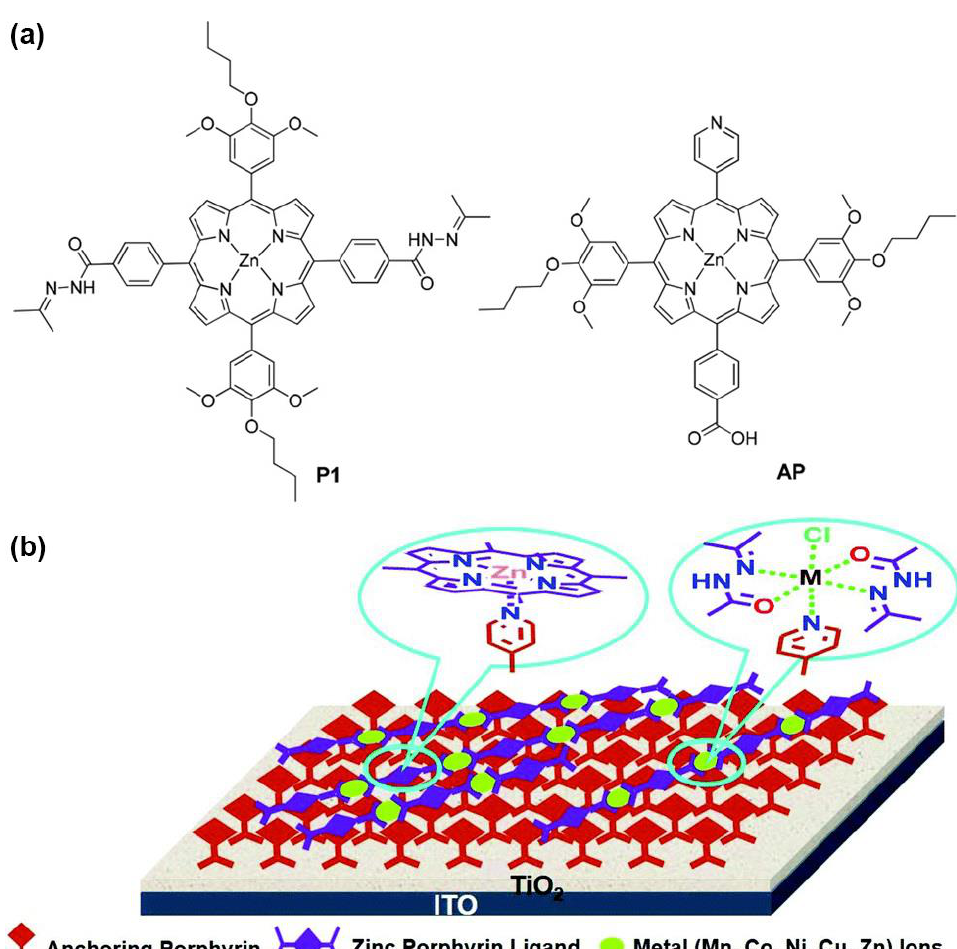
Figure 7. ( a ) Chemical structures of porphyrin ligand P1 and anchoring porphyrin AP; ( b ) modes of axial coordination-bond-assisted bilayer chromophores on TiO 2 electrode surfaces. Adapted from reference [59] with permission from the Royal Society of Chemistry, copyright 2016.